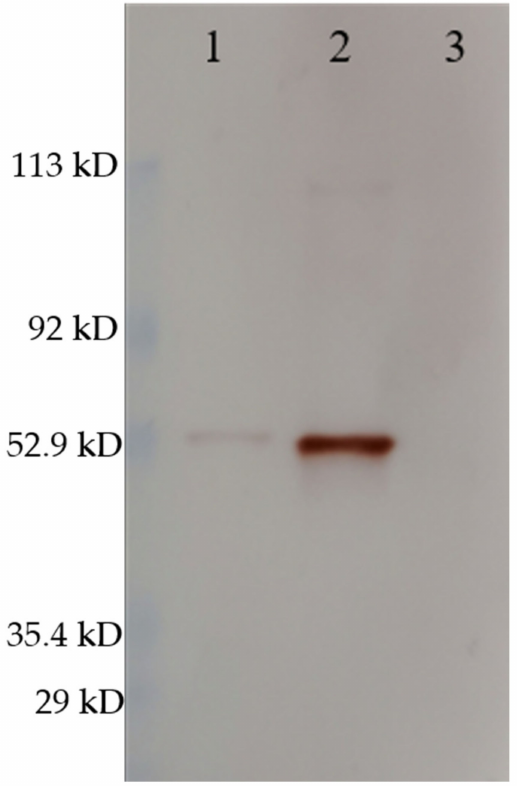
Figure 3. Western blot stained with rabbit-anti-nodavirus. (1) RGNNV (strain 283.2009), (2) RGNNV VLP, (3) MilliQ H 2 O. The RGNNV sample was concentrated virus obtained by ultracentrifugation of cell culture supernatant and was not quantified since impurities from the cell culture medium would contribute to total protein. The molecular weight indicated by the marker must be interpreted with caution since the marker was pre-stained (as described in Section 2.3). Uncropped photos are shown in the supplementary material (Figure